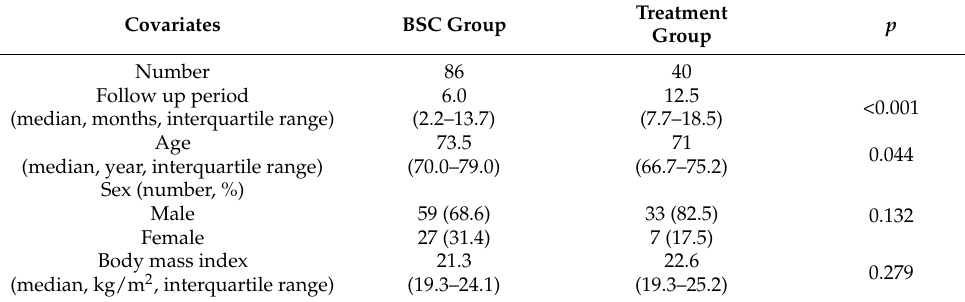
Table 1. Patient clinical